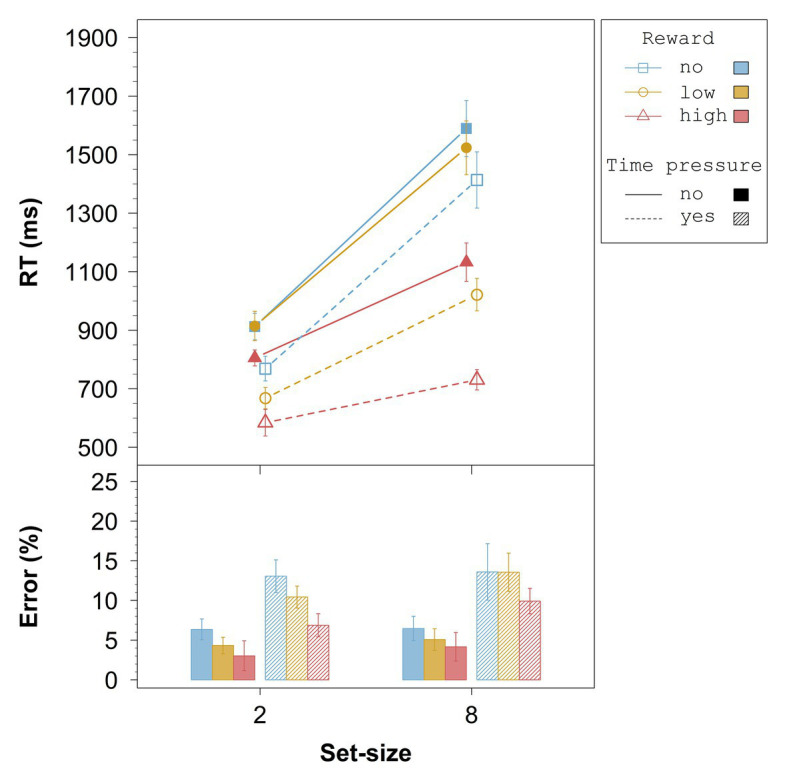
Averaged overall data from Experiment 1. Error bars represent 95% within-subject confidence intervals (Loftus and Masson, 1994; Morey, 2008). RT = response time.